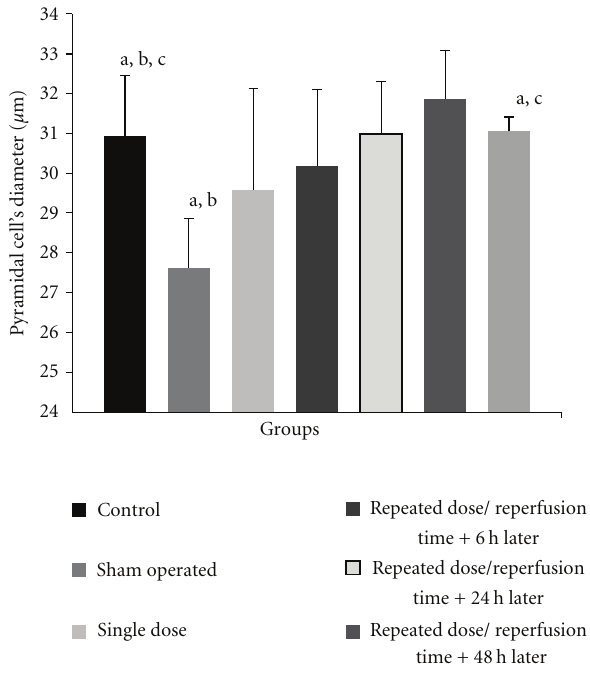
Figure 3: The e ff ect of FK506 (6mg/kg injection IV and 4 injections IP in various times) on pyramidal CA1 cells diameters after transient global ischemia. a,b,c P < 0 . 05 control (a) versus sham- operated (b) and repeated dose/reperfusion time +72h later (c) groups.